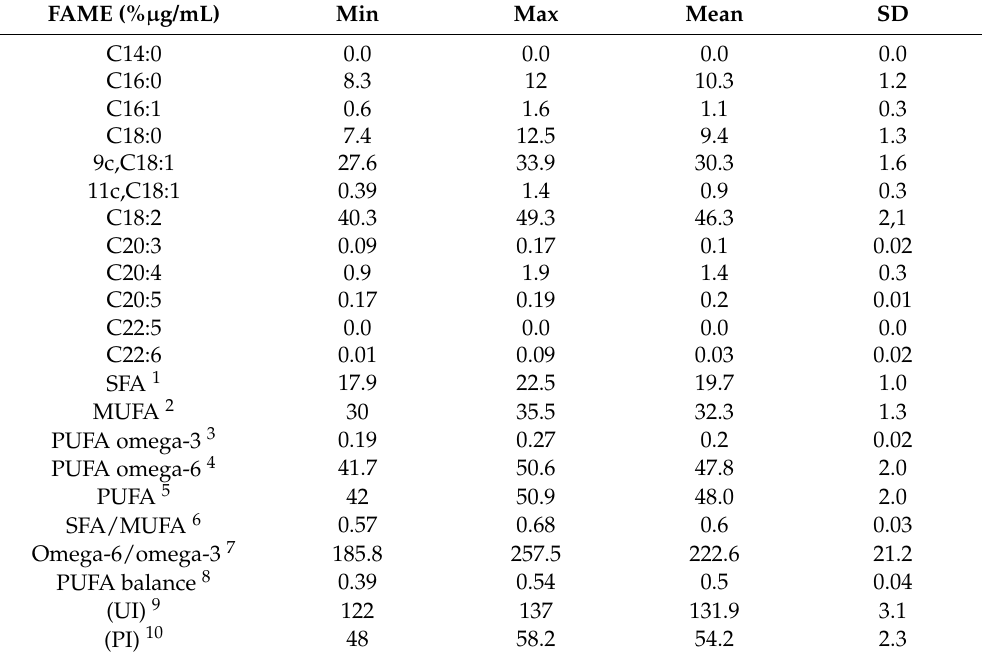
Table 4. Cohort of 12 Fatty Acids Expressed as Percentages of the Found µ g/mL Quantities Detected by Gas Chromatographic Analyses of the Fatty Acid Methyl Esters (FAMEs) after Isolation and Workup Erythrocyte Membrane Glycerophospholipids of 26 Healthy Donkeys. FAME (% µ g/mL) Min